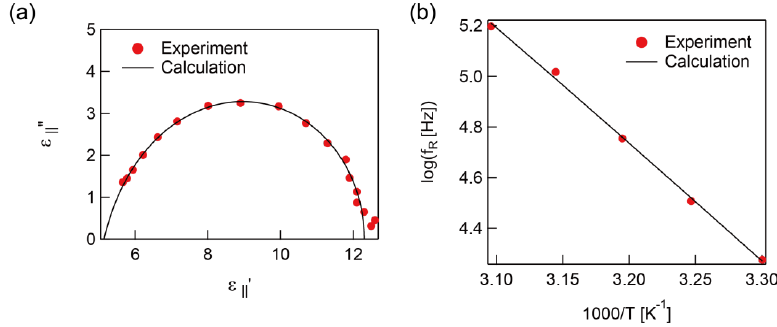
Figure 3. ( a ) The Cole-Cole plot of the unpolymerized sample at 303 K; ( b ) Temperature dependence of the relaxation frequencies of ε " before polymerization. The filled circles are ǁ experimental data and the line is the calculated